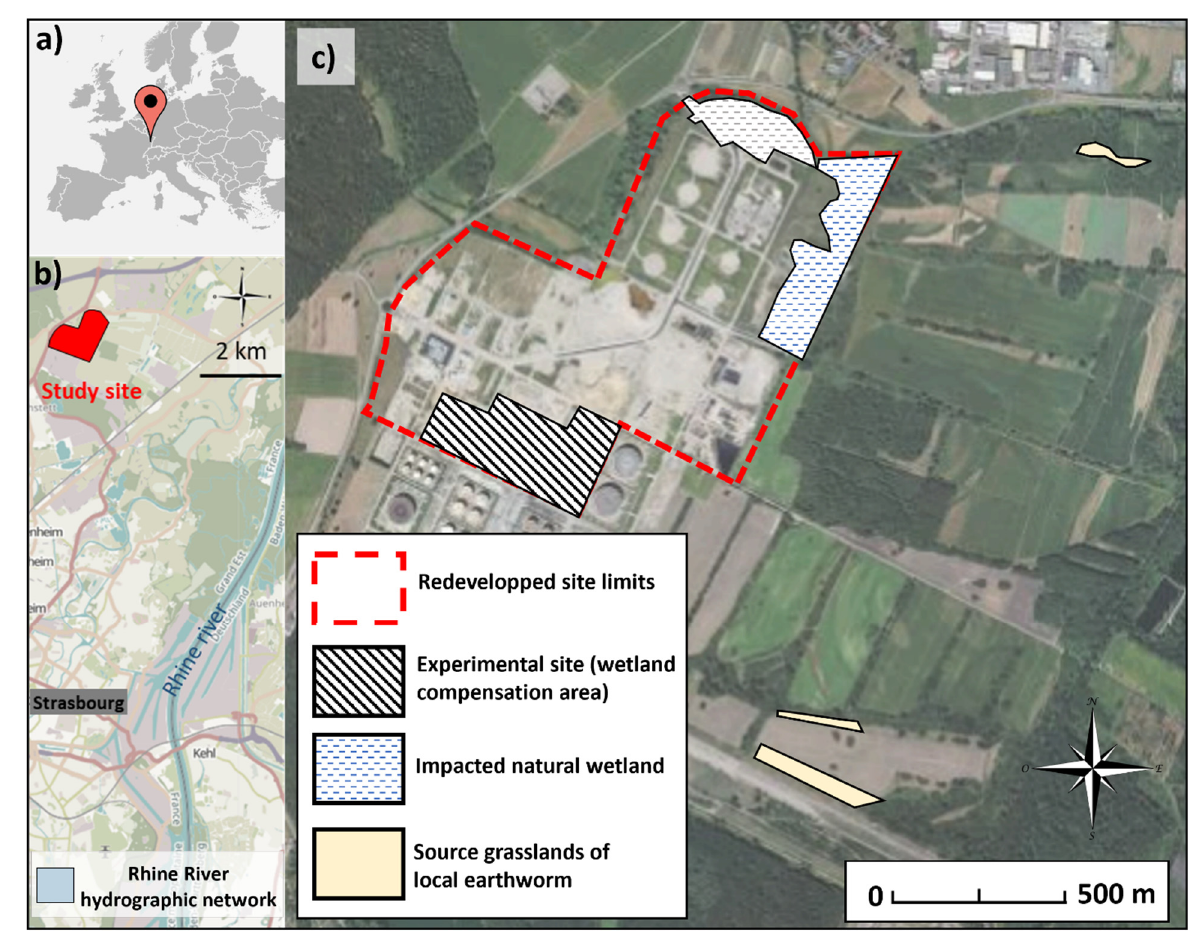
Figure 1. Study site location and delimitation. ( a ) Study site location in eastern France; ( b ) location of the site on the Rhine River floodplain; ( c ) experimental site and the grassland source area of the local earthworm communities. Map font sources: ( a ) Wikimedia common CC by SA2.0 [58]; ( b ) © OpenStreetMap, ODbl, CC-BY-SA 2.0 [59]; ( c ) Maps data, Google Earth,© 2022 Landsat/Copernicus [60].